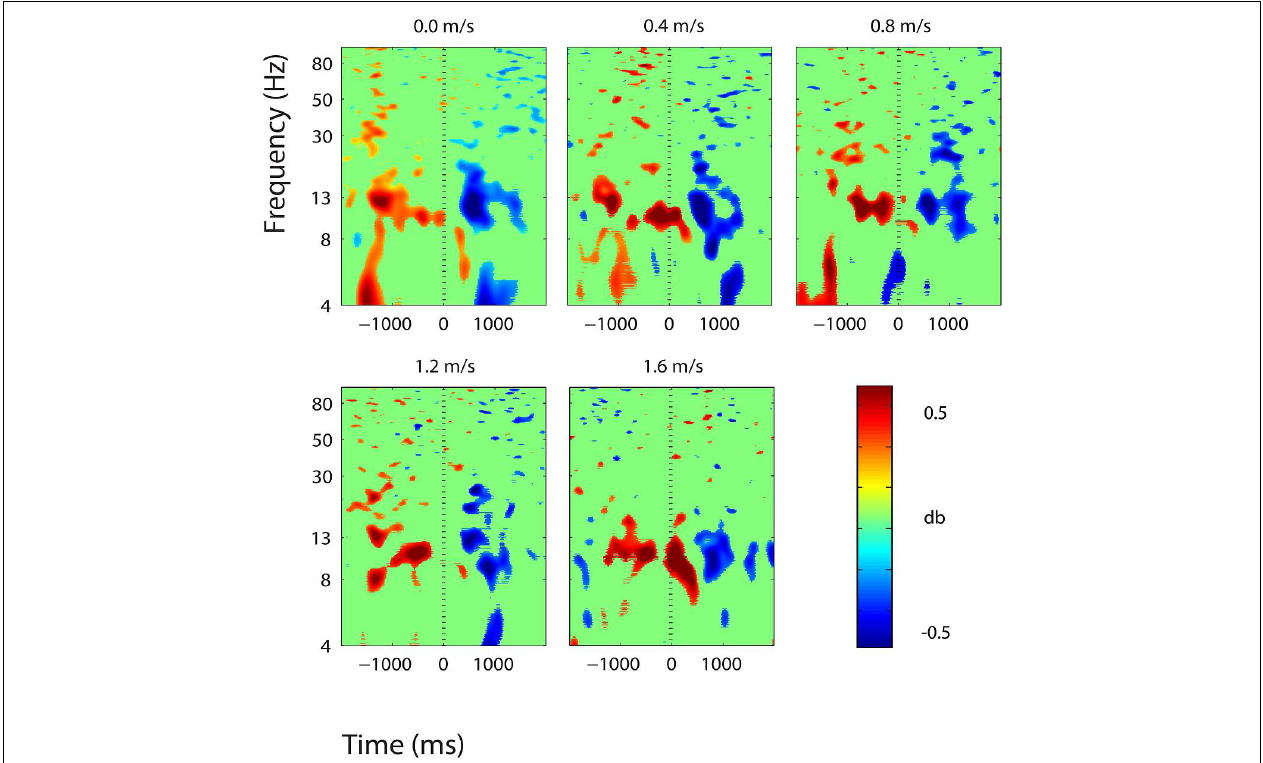
FIGURE 6 | Event-related spectral perturbation plots showing power change around the presentation of a stimulus (a digit and its position in an imagined grid) in the central somatosensory association cortex (BA 7). Red represents a power increase from